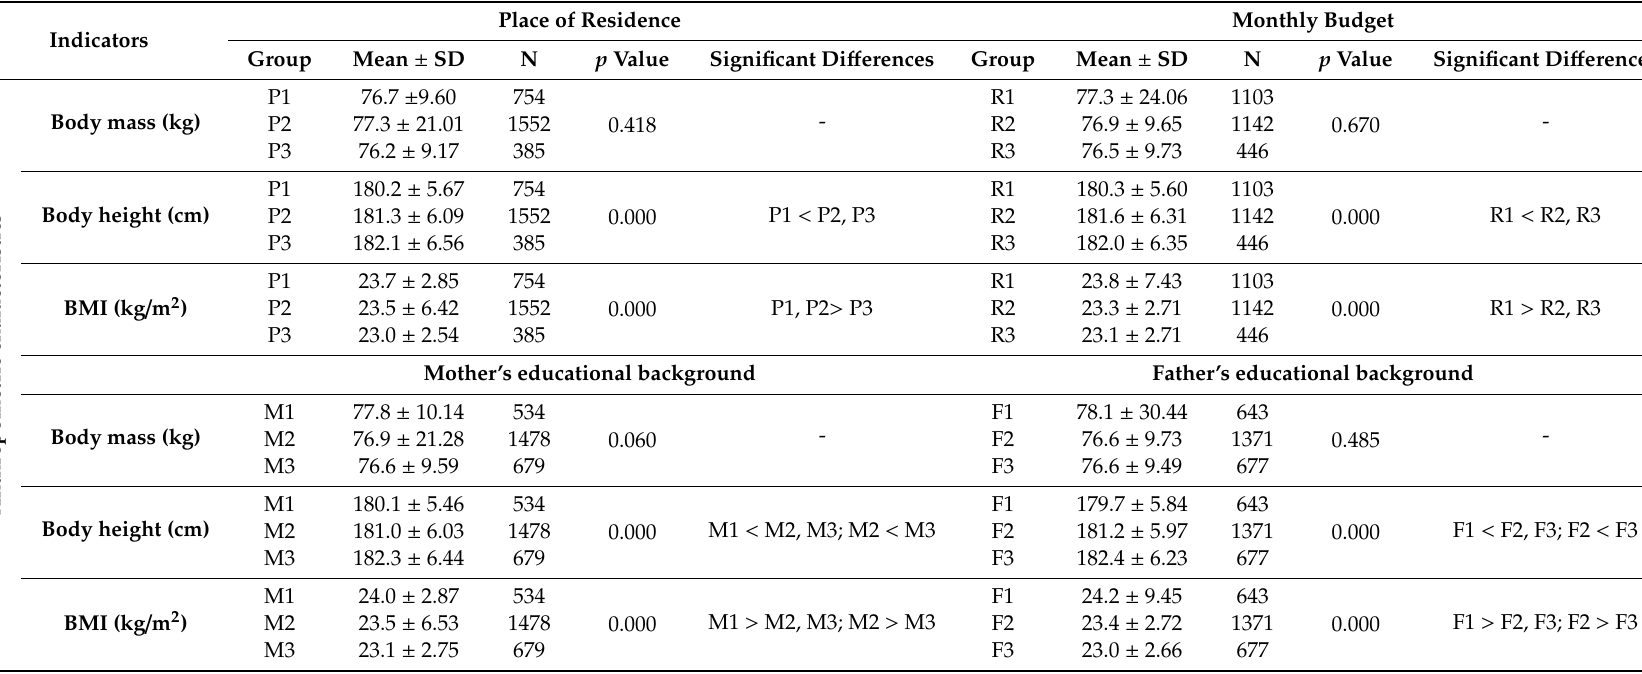
Table 2. Place of residence and monthly budget, mother’s and father’s educational background vs. anthropometric